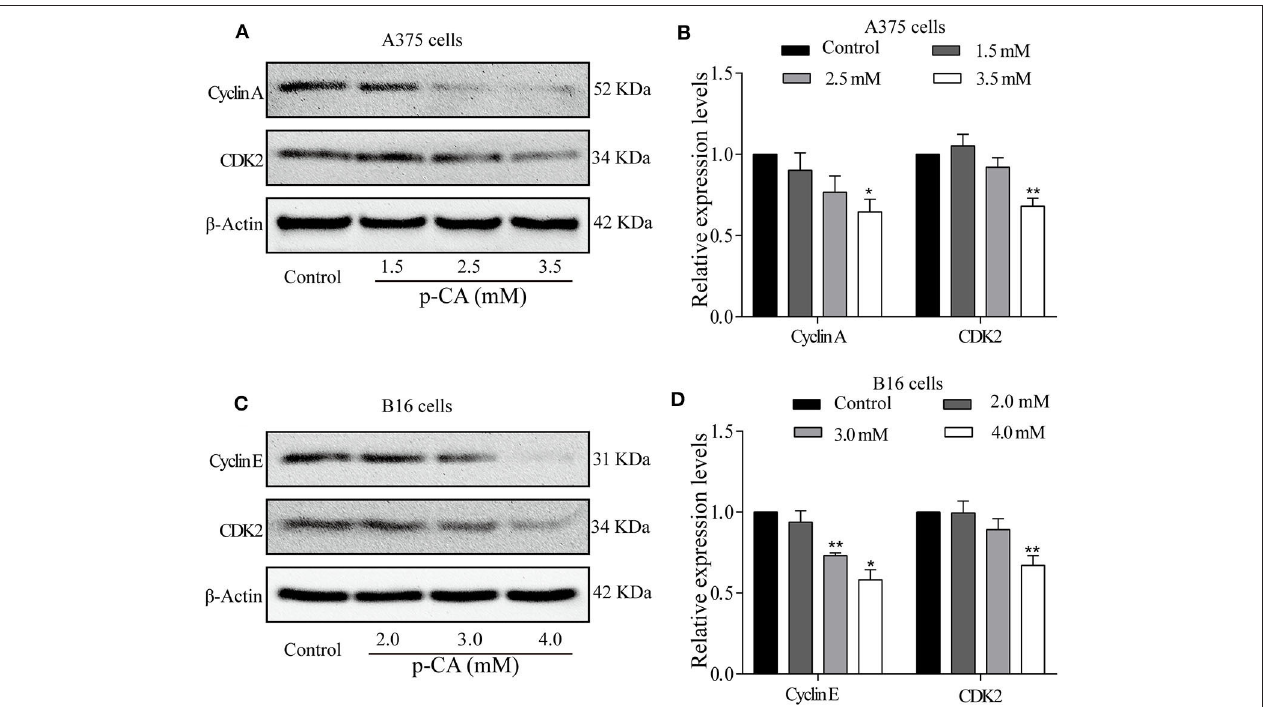
FIGURE 3 | p- CA regulates the activity of Cyclin–CDK complexes and cell cycle progression. (A) The protein levels of Cyclin A and CDK2 in A375 cells treated with p- CA, as measured by western blot. (B) Statistical analysis of Cyclin A and CDK2 levels in A375 cells. The ratio of protein levels was standardized according to the value of the control. (C) The protein levels of Cyclin E and CDK2 in B16 cells treated with p- CA, as measured by western blot. (D) Statistical analysis of Cyclin E and CDK2 levels in B16 cells. The ratio of protein levels was standardized according to the value of the control. All data are expressed as the mean ± SD of three independent experiments. * P < 0.05, ** P < 0.01 compared with the control.